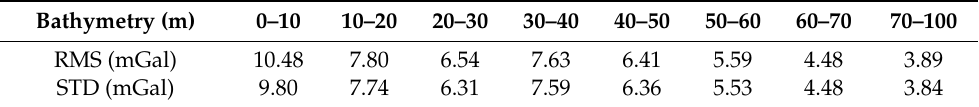
Table 4. Differences between SCSGA V1.0 and shipborne data since 1990 in deep waters with different submarine topography